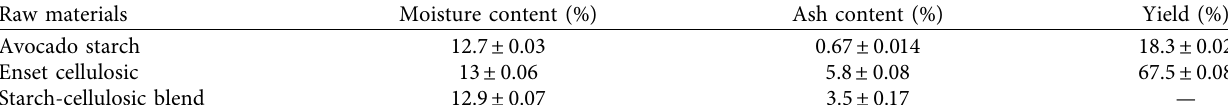
Table 1: Summary of the moisture content, ash content, and yield of the avocado starch and enset cellulosic.